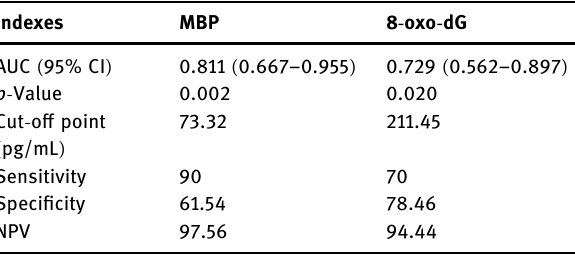
Table 3: The relation between MBP and 8 - oxo - dG and their pre - diction in